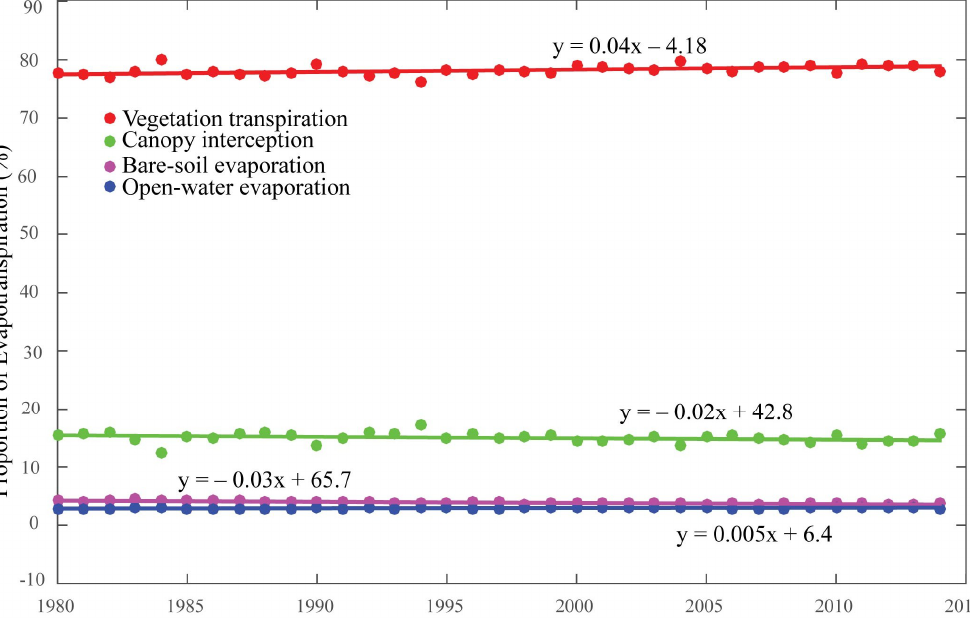
Figure 13. The interannual variations of each component’s proportion to land ET during the 1980–2014 period in the Nile Basin.